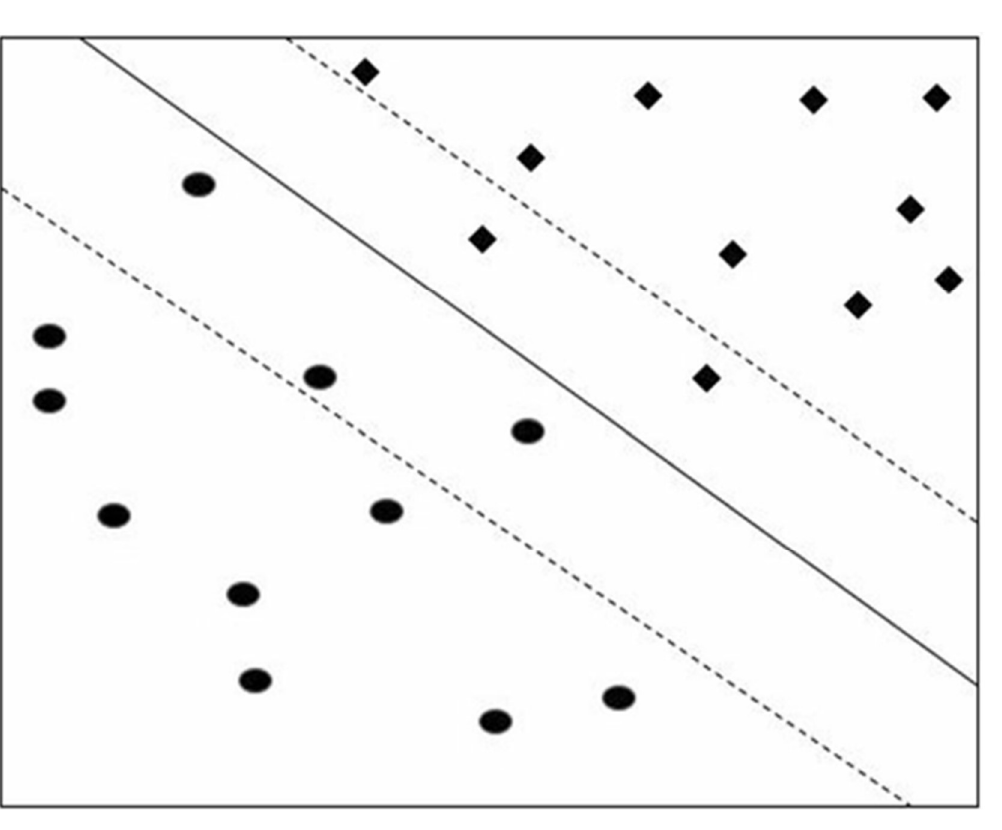
Figure 6. Concept of support vector machine (SVM).